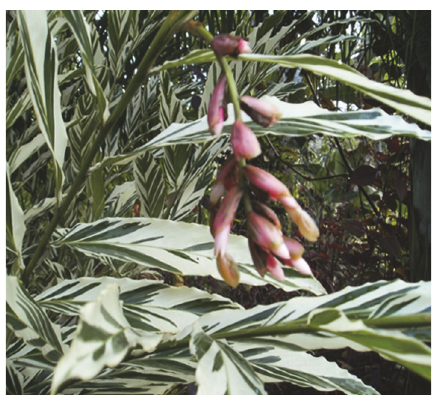
Figure 2: Alpinia vittata W.